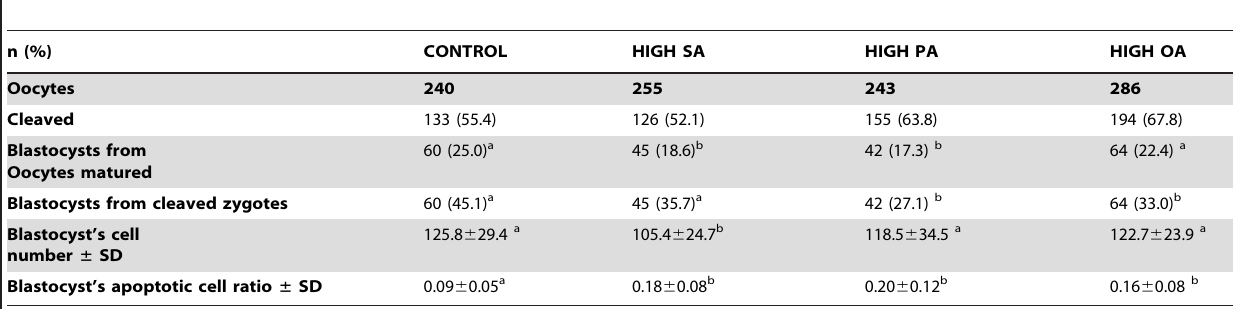
Table 1. NEFA exposure of bovine oocytes significantly reduced the oocyte developmental competence and the quality of the resultant